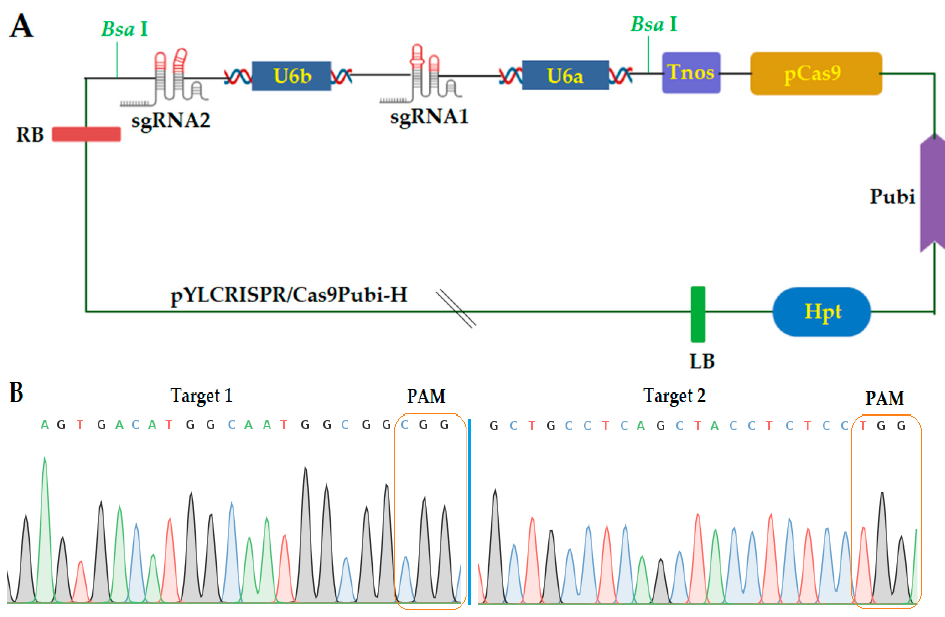
Figure 1. ( A ) Schematic representation of pYLCRISPR/Cas9 vector construction and ( B ) sequencing peak map of both target sites assembled in vector. sgRNA, single guided RNA; LB, left border; mpCas9, Cas9 protein; U6, rice U6 promoter; HPT, hygromycin phosphotransferase gene; Bsa, cutting sites; Pubi, maize ubiquitin promoter; Tnos: gene terminator, RB, right border; PAM, protospacer adjacent